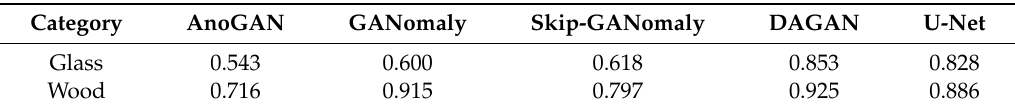
Table 3. AUCs of glass and wood datasets generated using AnoGAN, GANomaly, Skip-GANomaly, the proposed method (DAGAN), and U-Net